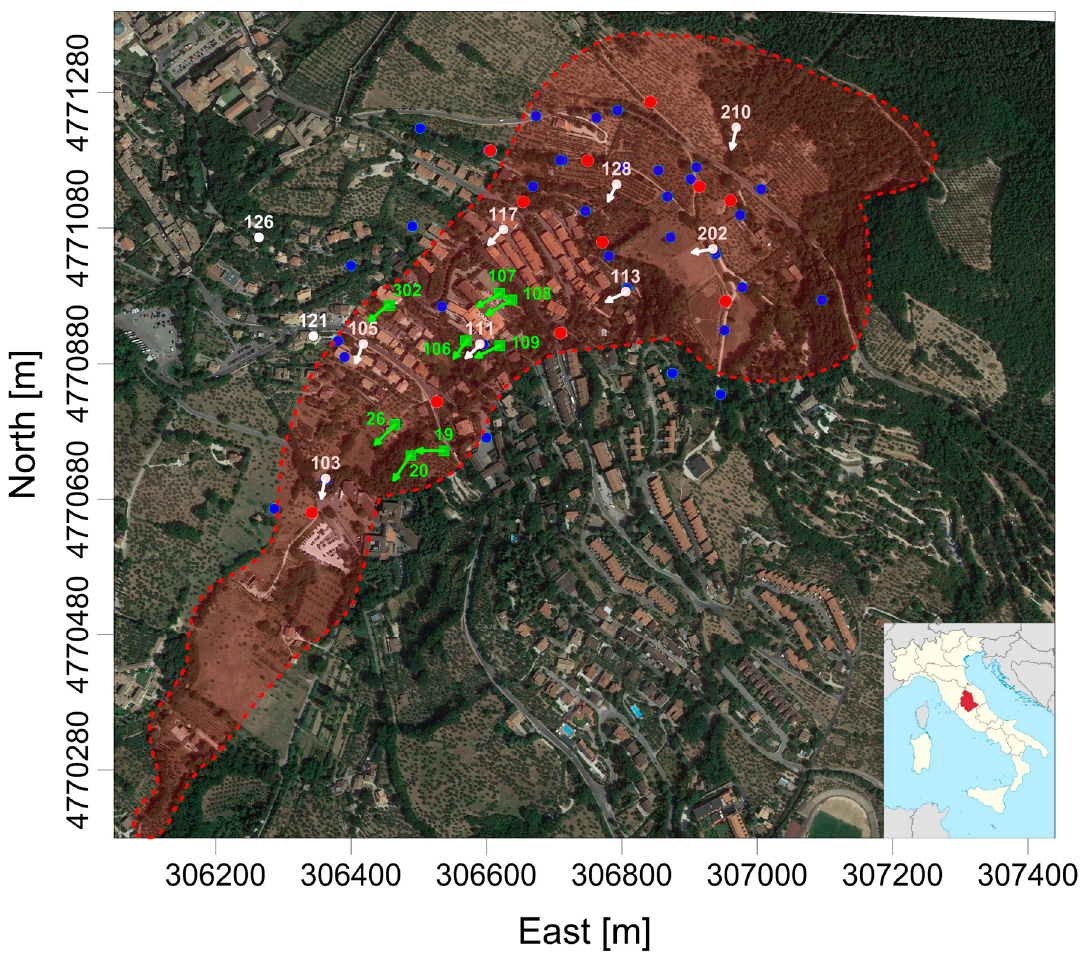
Figure 1. Study Area. Satellite optical image (source: Google Earth) of the Assisi surrounding area (Central Italy) affected by the Ivancich landslide. Insert map, lower right corner, reports the geographic location of the study area. Shaded area with red contour shows the zone involved by the recent slope instability phenomenon. All the circles represent borehole data: blue circles represent the 1998 survey; white circles are inclinometric boreholes (related to the same time period of the blue boreholes); red circles correspond to the 2006 survey. The green squares identify the previous inclinometric survey, acquired during 1982–1990 time interval. The arrows indicate the direction of the landslide movement.